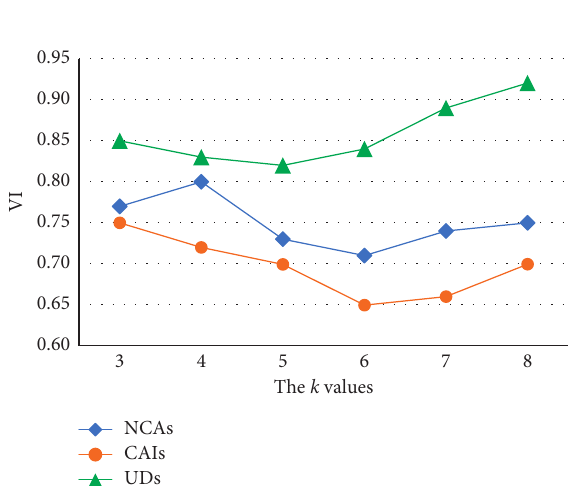
Figure 1: Calculation results.